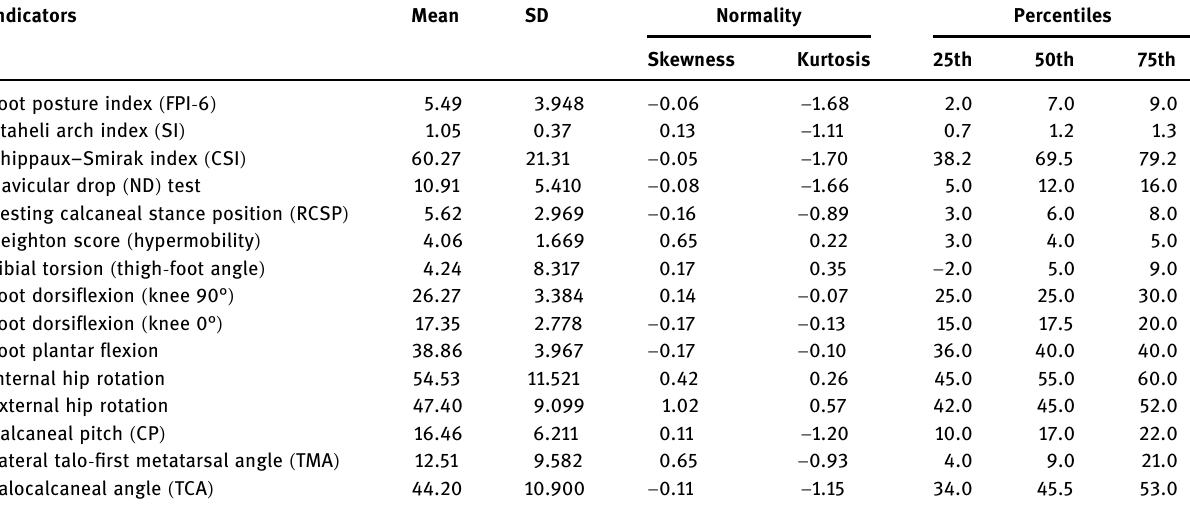
Table 2: Descriptive characteristics of analyzed indicators